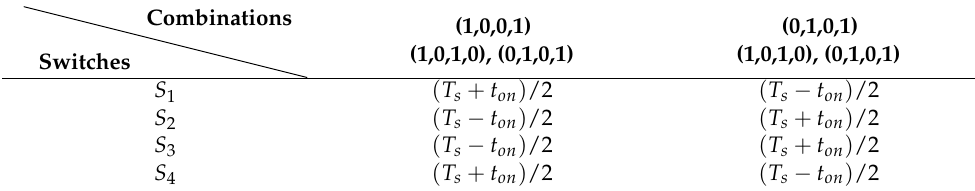
Figure 3. Possible switching vector combinations of the proposed MPCC. Table 3. The conduction time of each switch under the proposed